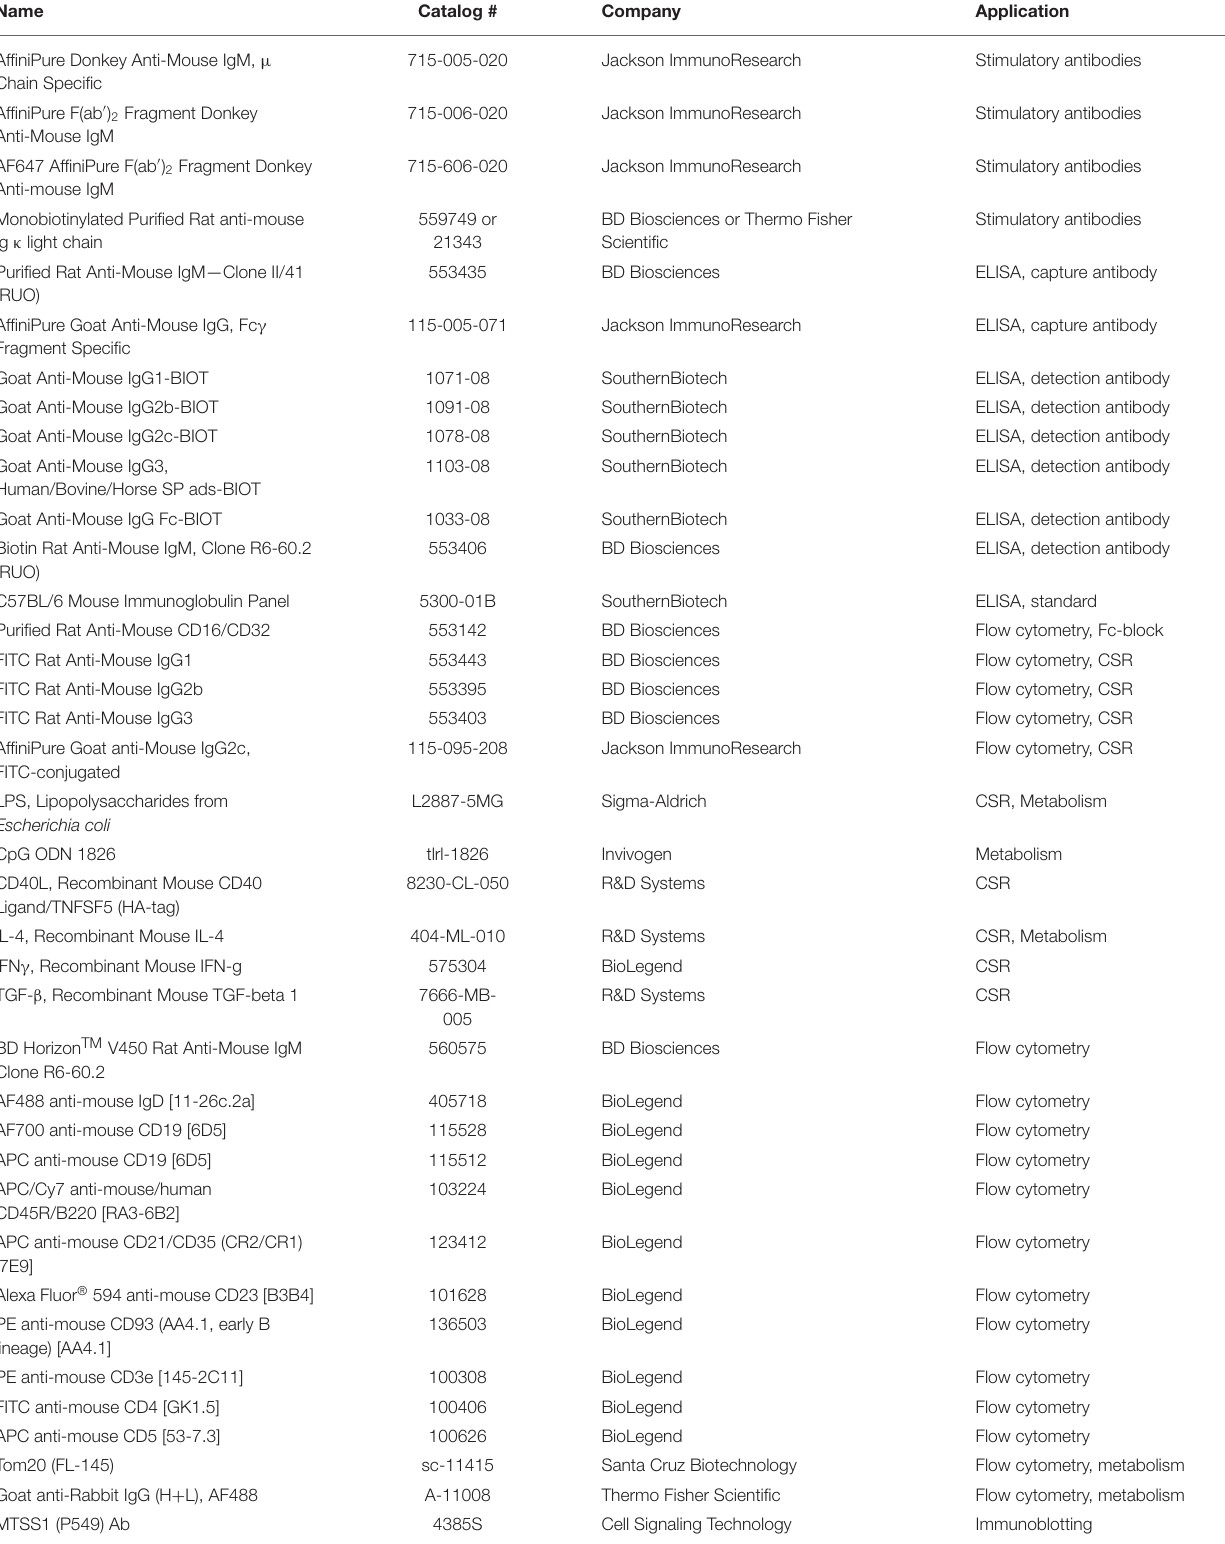
TABLE 1 | Key reagents table.